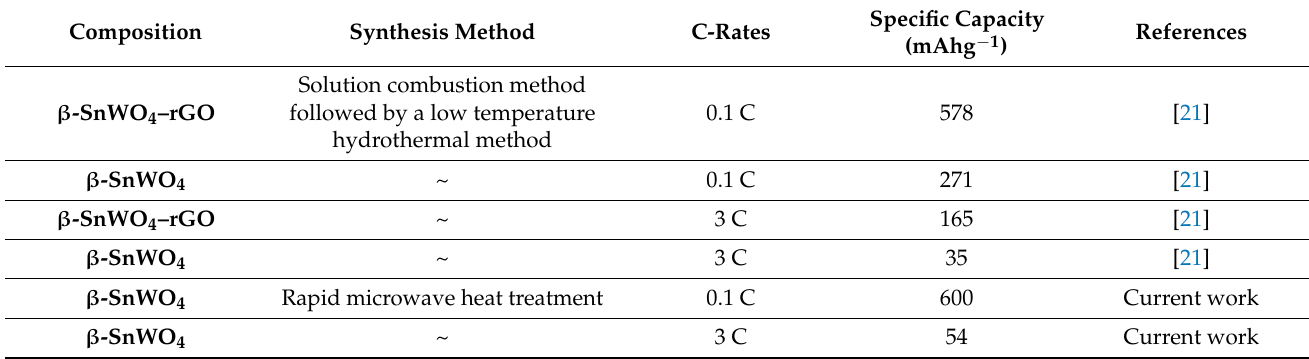
Table 2. Comparative study of specific capacities along different C-rates for pure β -SnWO 4 and for other dopants. Composition